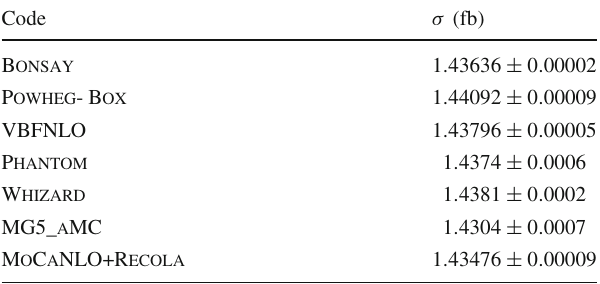
Table 3 Cross sections at LO accuracy and order O (α 6 ) . The com- plete 2 → 6 matrix-element, without any approximation, is employed by Phantom , Whizard , MG5_aMC , and MoCaNLO+Recola . The predictions are obtained in the fiducial region described in Sect. 3.3. The uncertainties shown refer to the estimated statistical errors of the Monte Carlo integrations